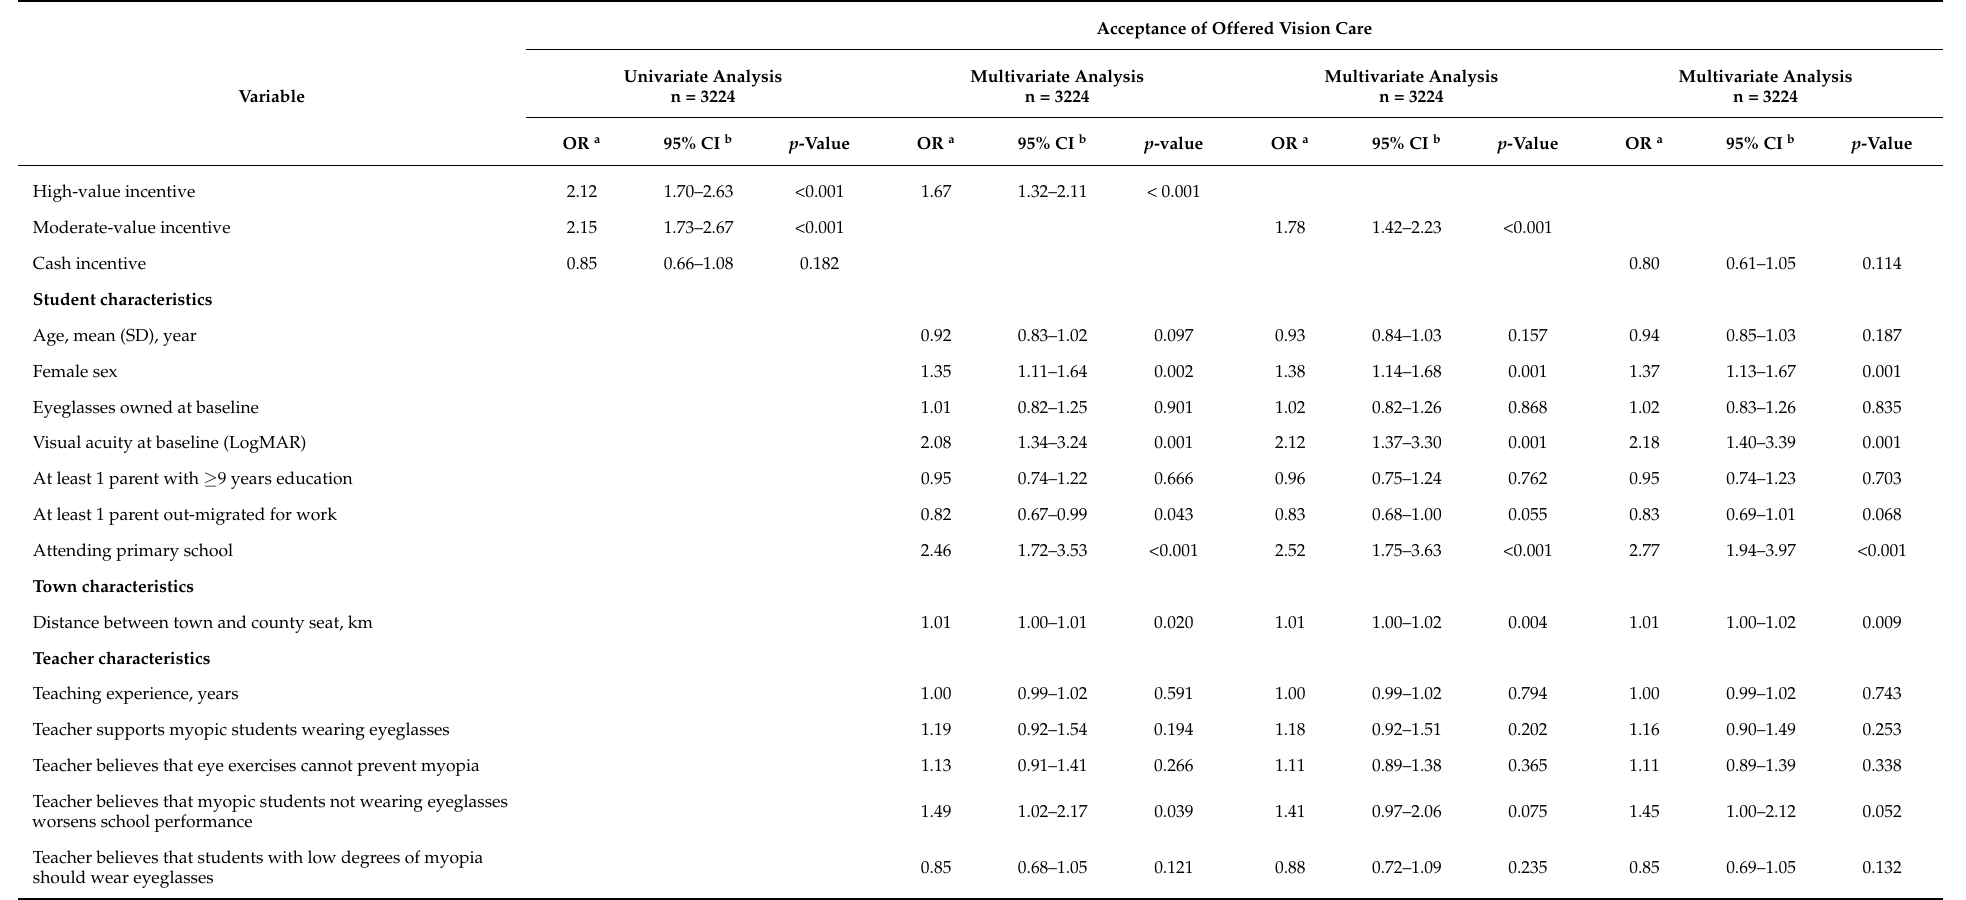
Table 5. Logistic regression analysis of the impact of providing different teacher incentives on students’ acceptance of offered vision